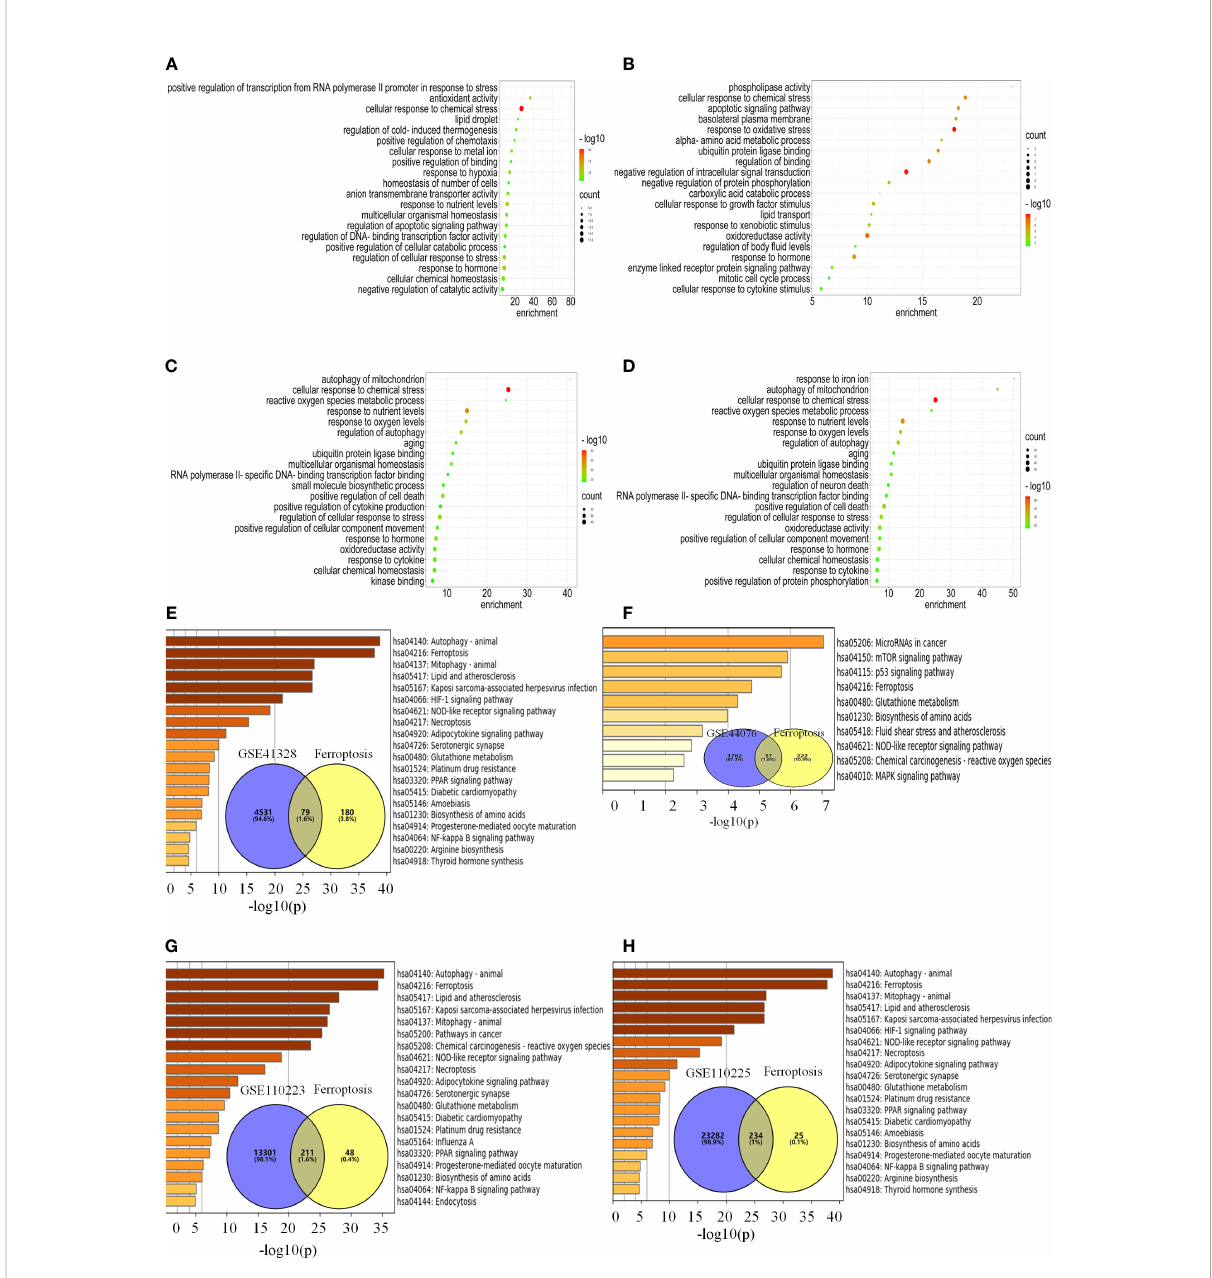
FIGURE 3 DEGs are engaged in biological processes and signaling pathways associated with ferroptosis. (A – H) Analysis of the pathway for ferroptosis- related differential genes for each data set. (A – D) Enrichment analysis of biological processes associated with ferroptosis-related differential genes for each data set. (E – H) Venn diagrams and enrichment analysis of the KEGG pathway for ferroptosis-related differential genes for each data